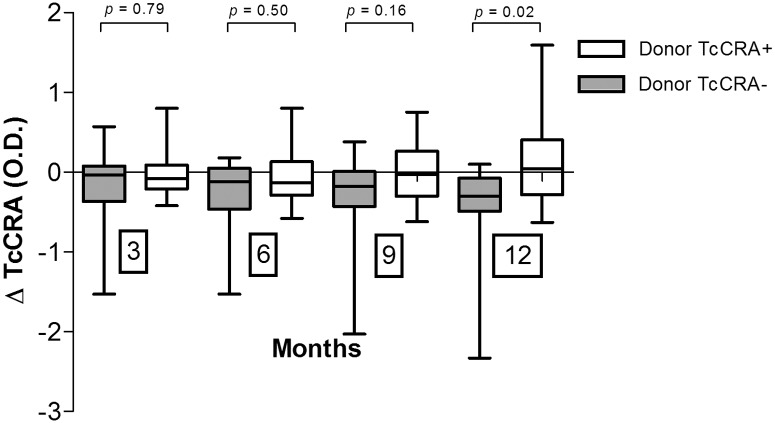
Effect of donor’s TcCRA serological status on patients’ TcCRA-signal evolution.ΔTcCRA was calculated at 3, 6, 9 and 12 months after graft to evaluate the gain or loss in TcCRA signal. The numbers of available samples at 3, 6, 9 and 12 months were respectively 41, 39, 31 and 27.